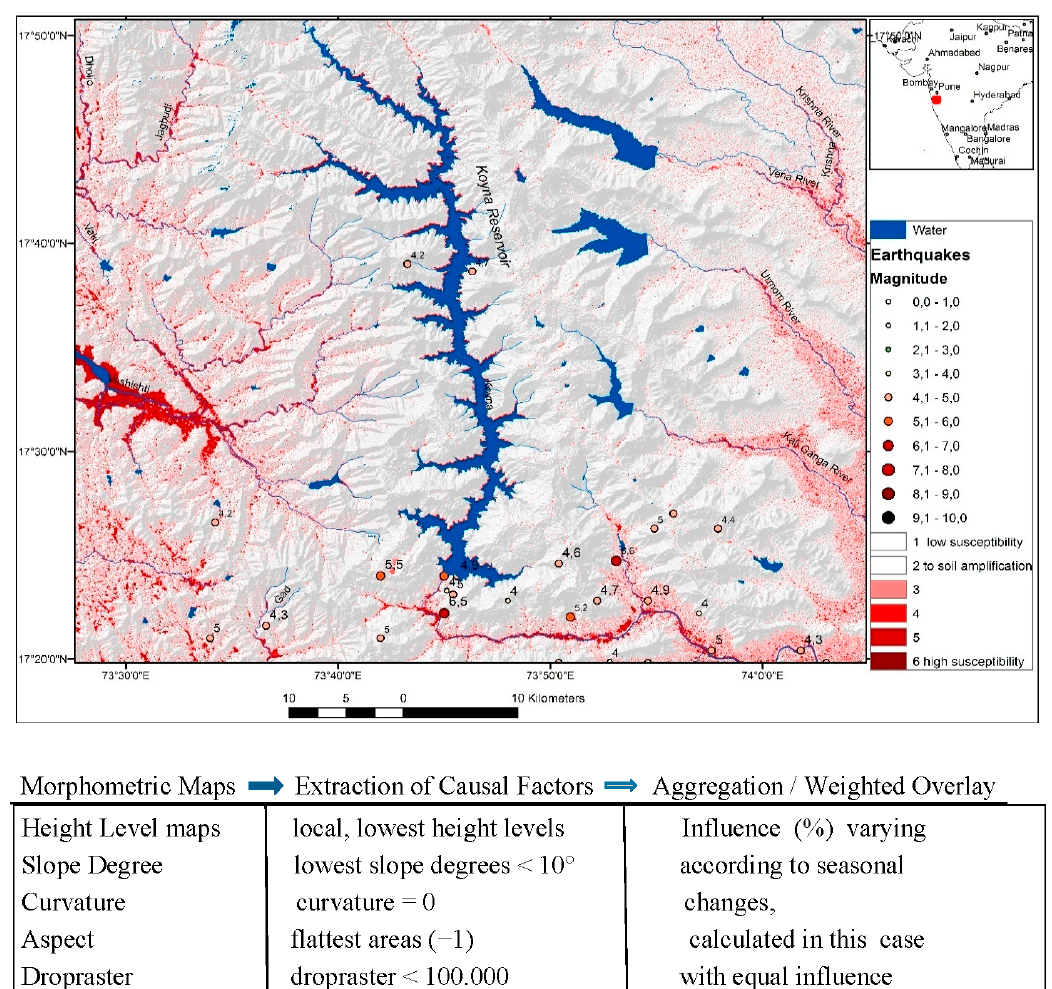
Figure 8. Weighted overlay of causal, morphometric factors influencing the susceptibility to soil amplification. Dark red areas are correlated with relatively higher susceptibility due to their morphometric